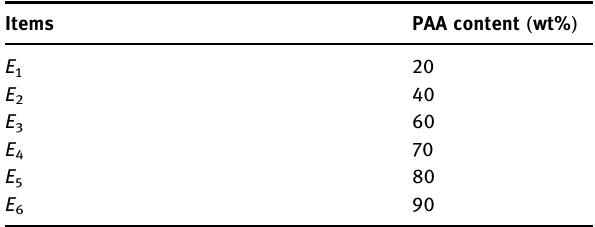
Table 1: Component table of EP/PAA